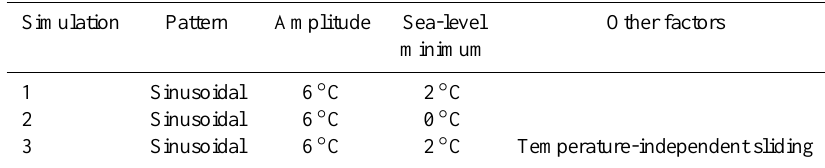
Table 2. Landscape evolution and orographic precipitation model